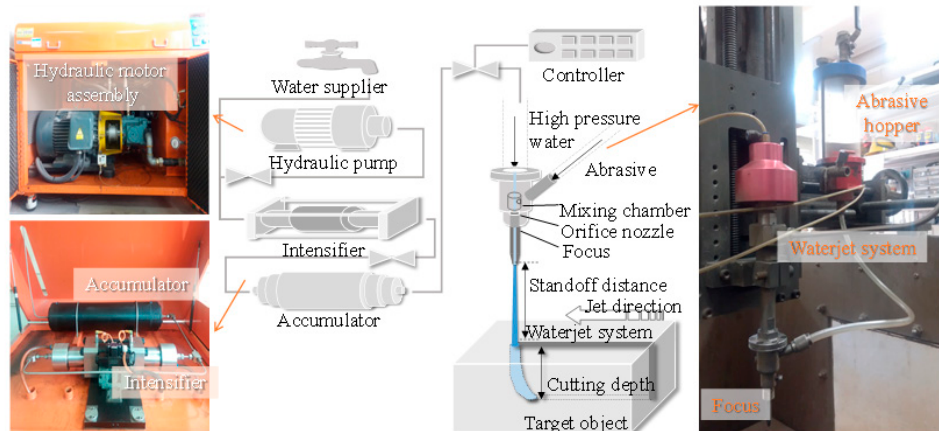
Figure 4. Experimental setup for abrasive waterjet rock cutting with pump and abrasive waterjet system.